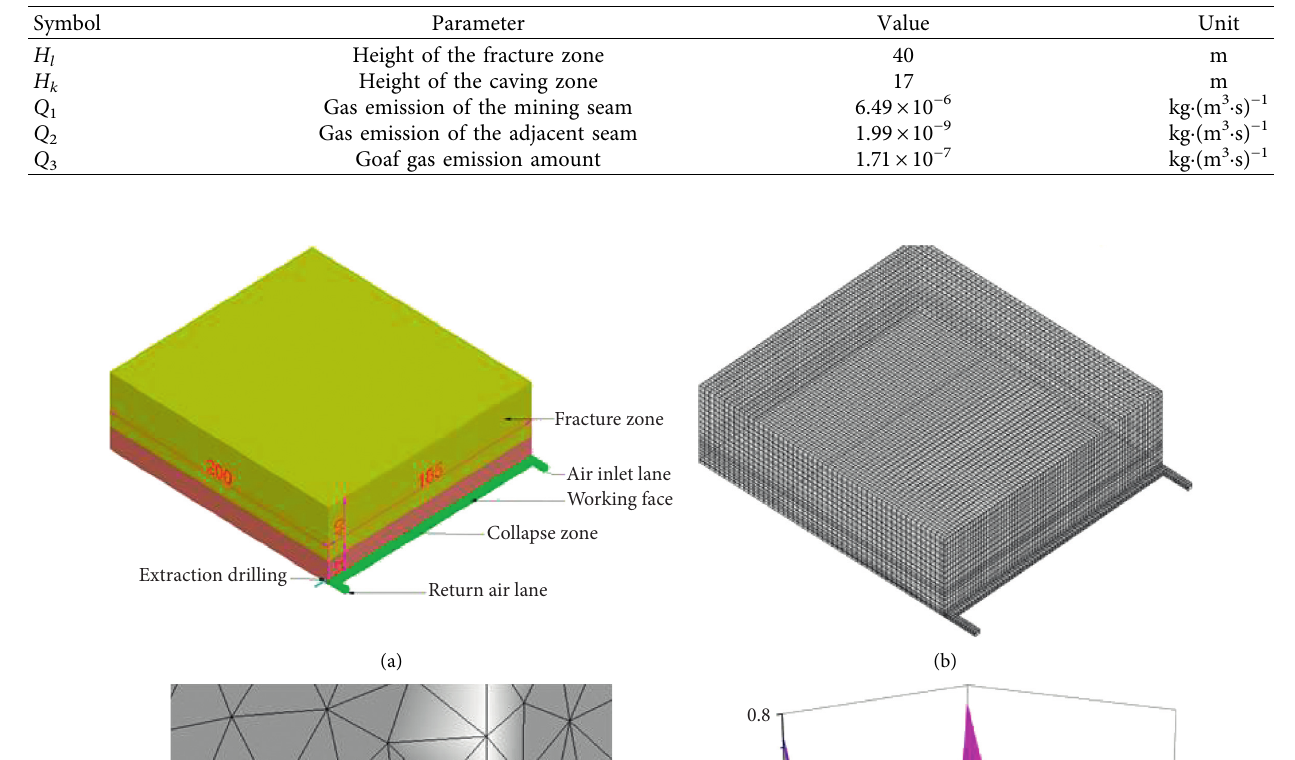
Table 2: Physical parameters of the numerical model.